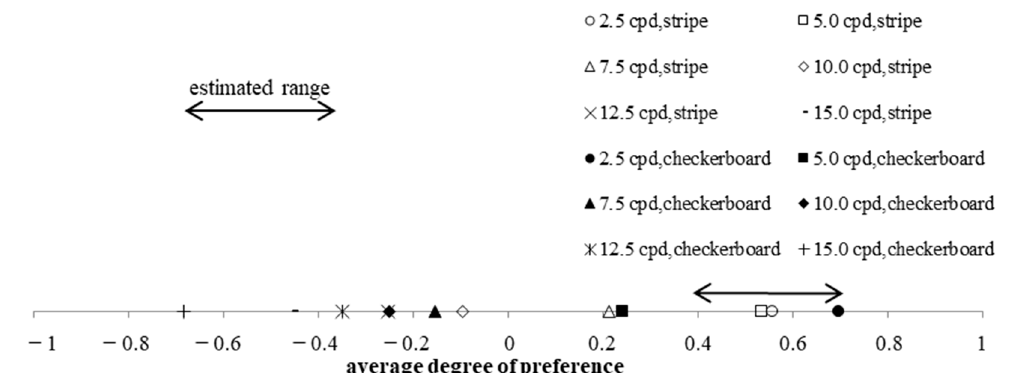
Figure 7. In terms of spatial frequency brightness perception between the stripes and the checkerboard pattern, the 2.5 cpd checkerboard pattern was the brightest result. There was no significant difference between the 5.0 cpd stripes and the 2.5 cpd stripes, and the 2.5 cpd checkerboard pattern.